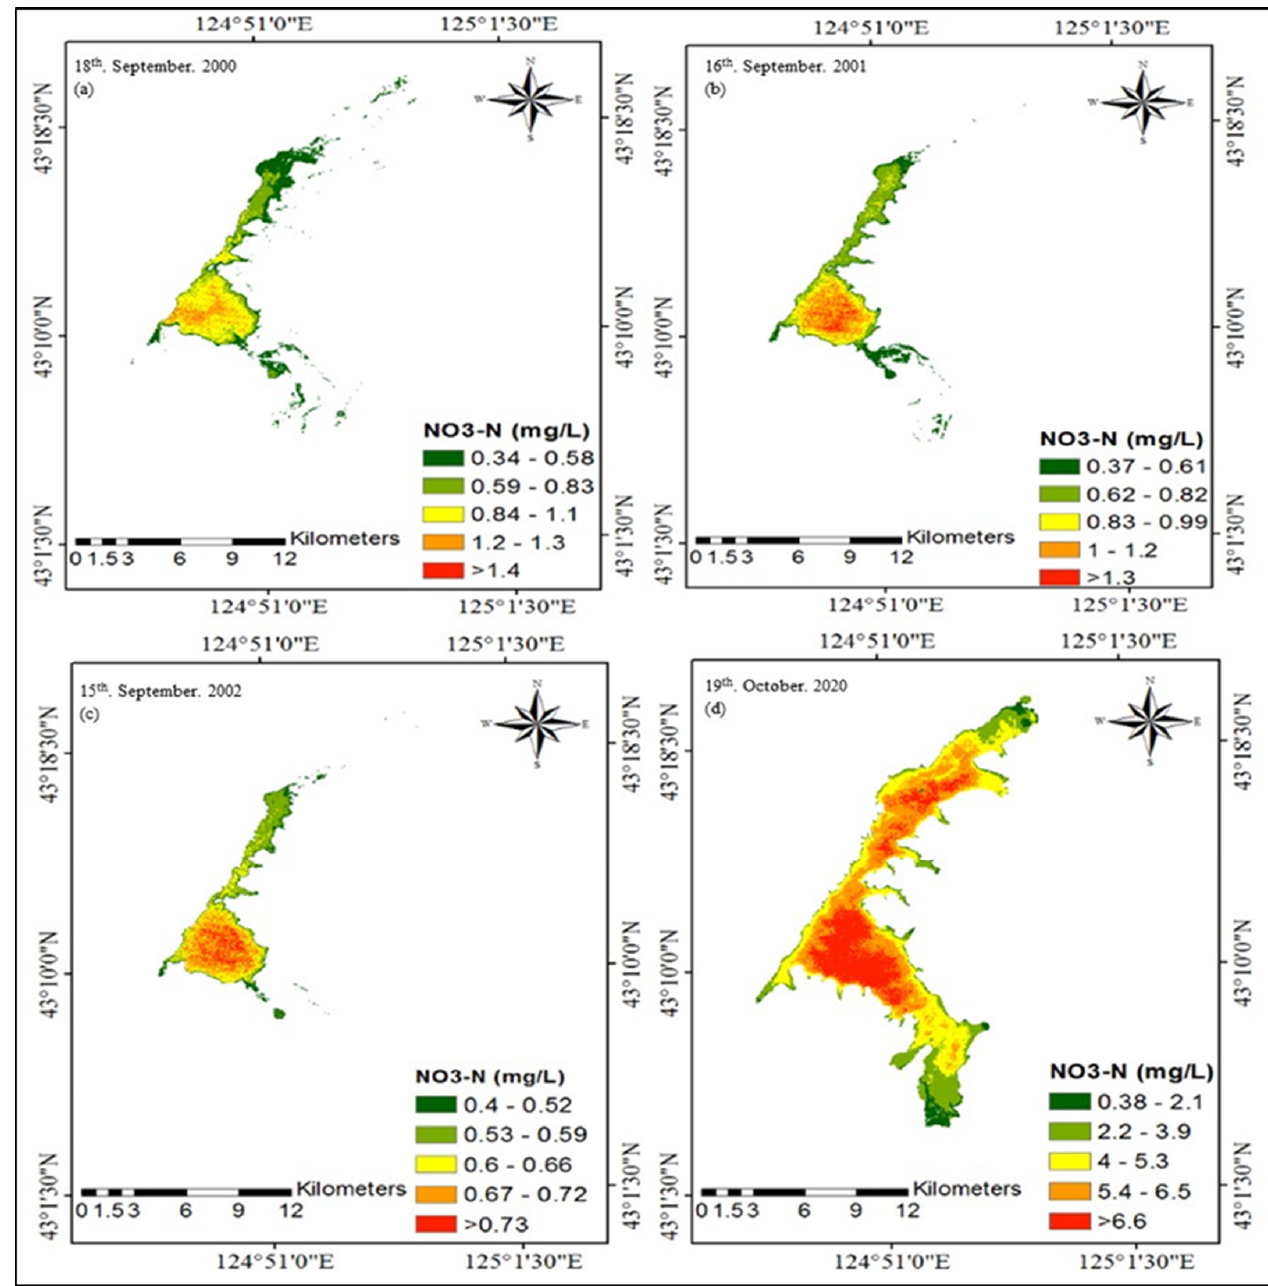
Figure 7. Spatial distributions of NO 3 -N (( a ) spatial distributions of NO 3 -N on 18 September 2000, ( b ) spatial distributions of NO 3 -N on 16 September 2001, ( c ) spatial distributions of NO 3 -N on 15 September 2002, ( d ) spatial distributions of NO 3 -N on 19 October 2020), estimated via models generated from Landsat (TM, ETM, and OLI8) in Erlong Lake.